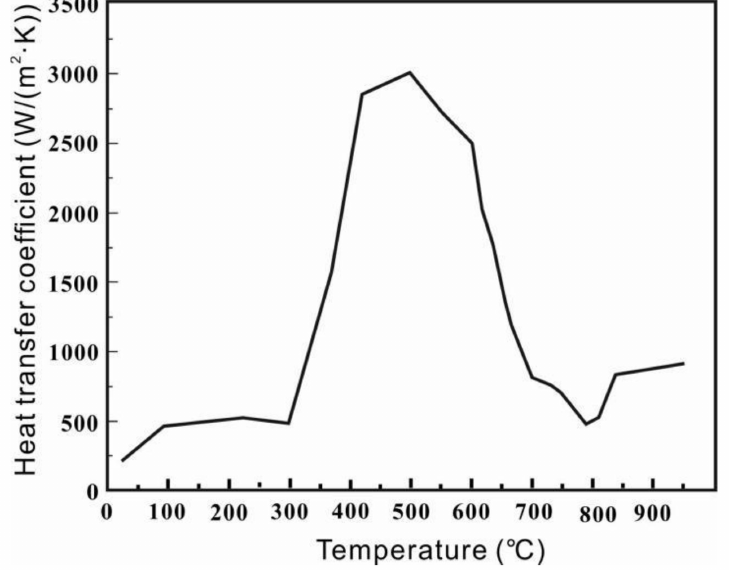
Figure 6. Heat transfer coefficient between 20Cr2Ni4A steel and HQG